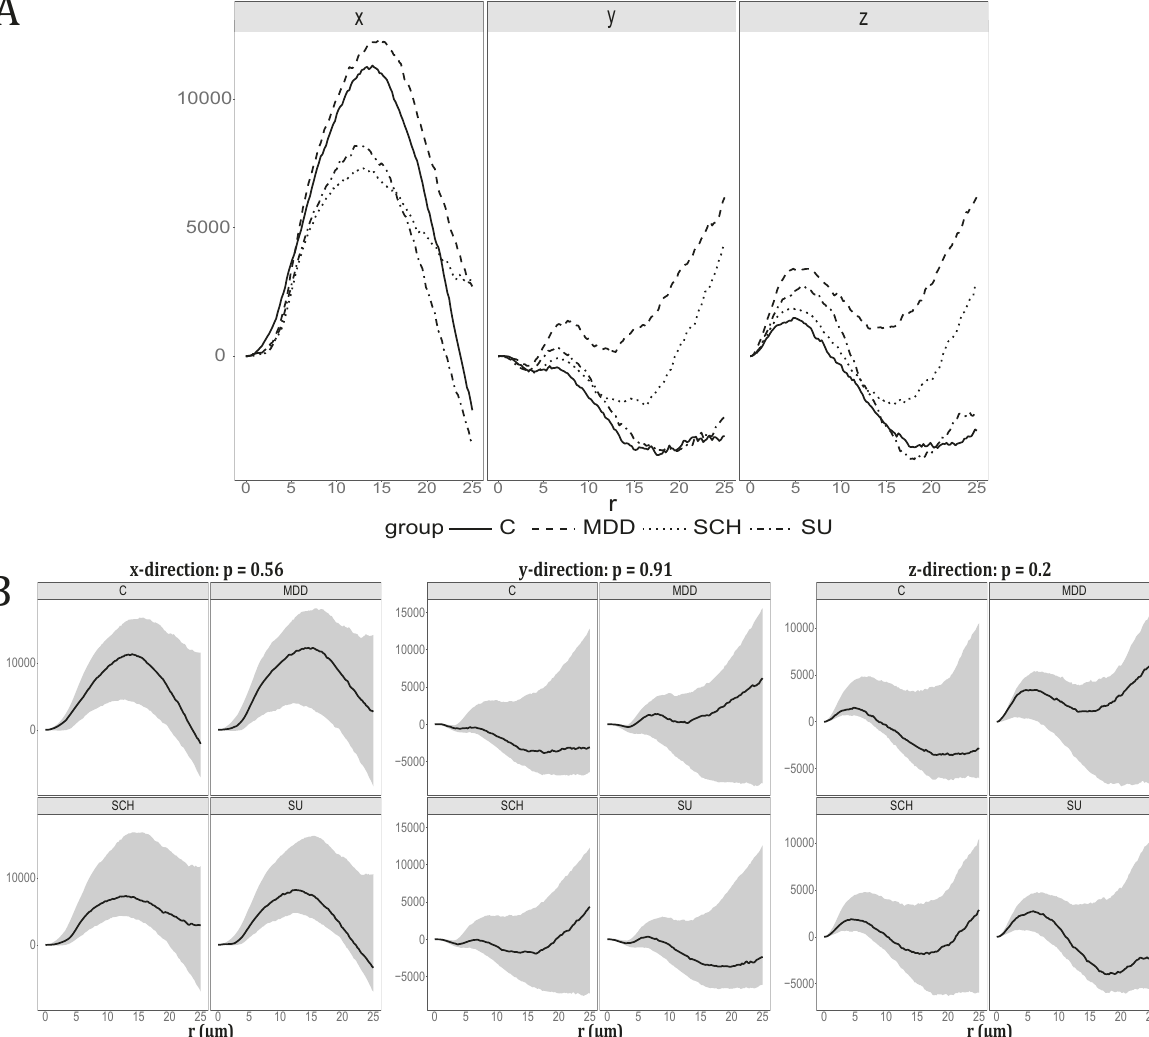
Fig. 4 Spatial point pattern analysis. A Plot of the weighted mean of each group. The weighted mean of the empirical cylindrical K -functions minus the theoretical value under CSR in the direction shown at the top. The line type corresponds to the groups: Control (C), Major depressive disorder (MDD), Suicide (SU), and Schizophrenia (SCH) as stated in the legend. B Test the difference between groups in the x , y , and z -axes.95% Global envelope test for testing the hypothesis of no differences in the cylindrical K-functions of the four groups Control (C), Major depressive disorder (MDD), Suicide (SU), and Schizophrenia (SCH). There is a test for the cylindrical K -function in each of the directions of the x -, y -, and z -axes. The 95% global envelopes (gray area) were based on 8000 random permutations. The solid curves are the estimates obtained from data after the theoretical value under CSR was subtracted. The direction is stated at the top of each plot, as well as the p -value of the where neurons are traveling through the coloumnar structure, suggesting that SCH, MDD, and SU are not neuronal migration disorders.